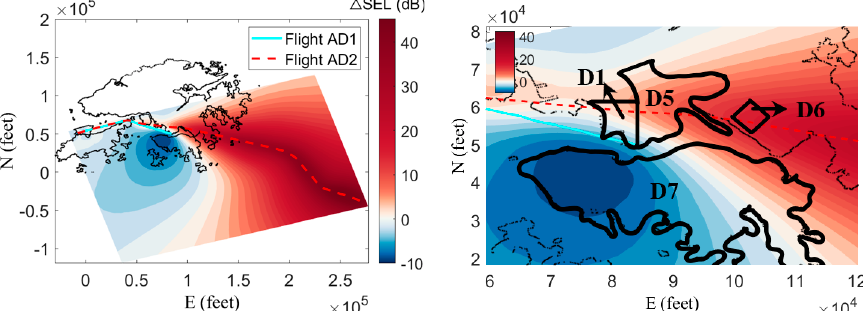
Figure 11. Difference in the noise impact ( ∆ SEL) by flights AD1 and AD2 (as obtained by subtracting the former from the latter), with a closer view provided on the right side.